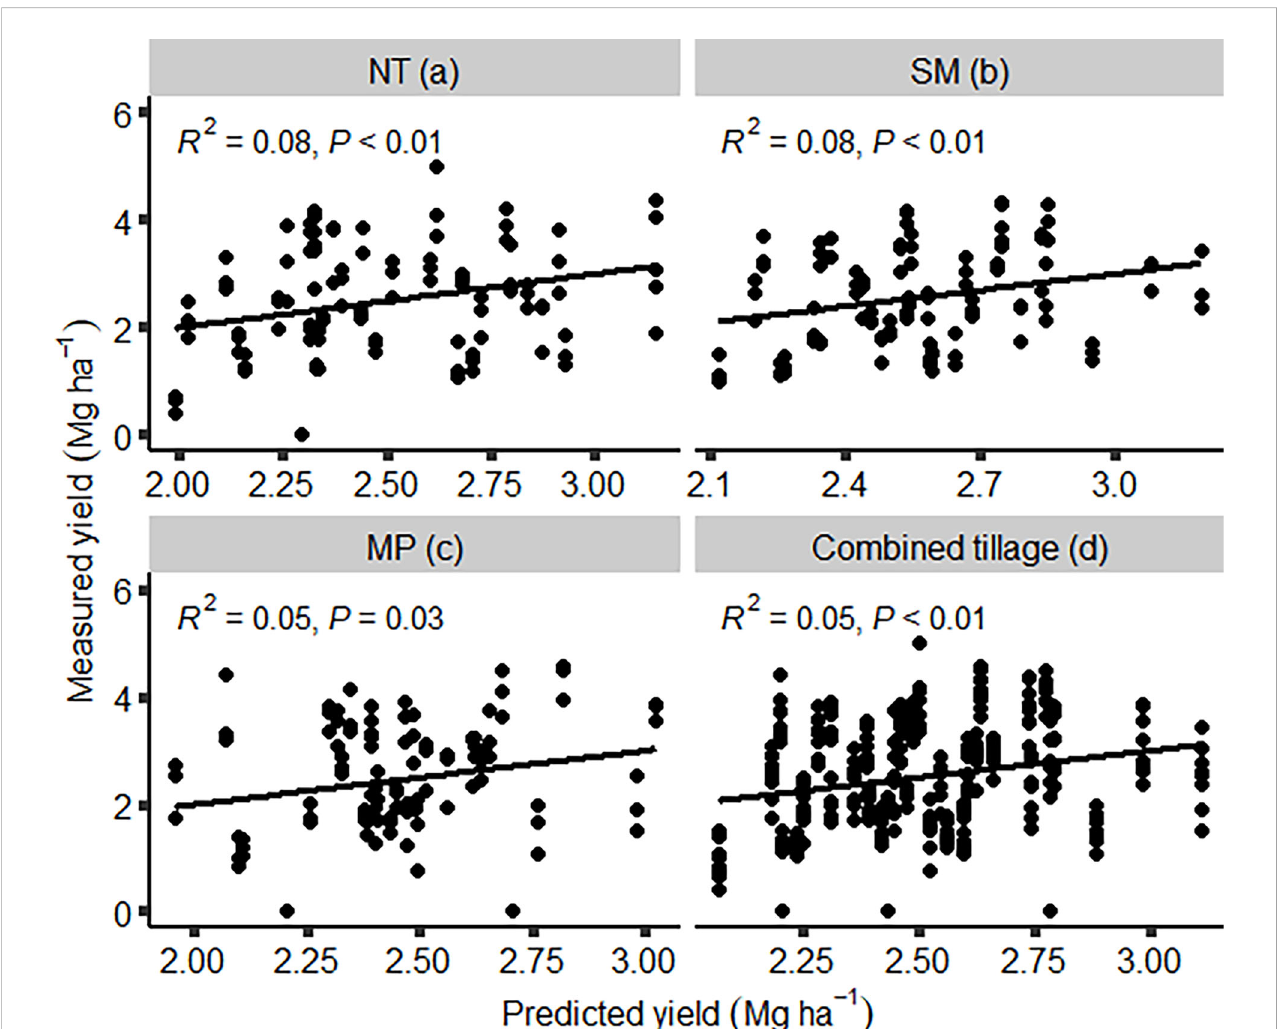
FIGURE 3 The relationship between predicted and measured winter wheat grain yield under different tillage practices with yield predicted using precipitation received at three different periods of the season by fi tting and validating a multiple linear regression model. The tillage practices were NT (A) , SM (B) , MP (C) , and combined tillage (D) . k-fold cross-validation ( k = 10 ) was used to evaluate model performance. NT, no-till; SM, stubble mulch; MP, moldboard